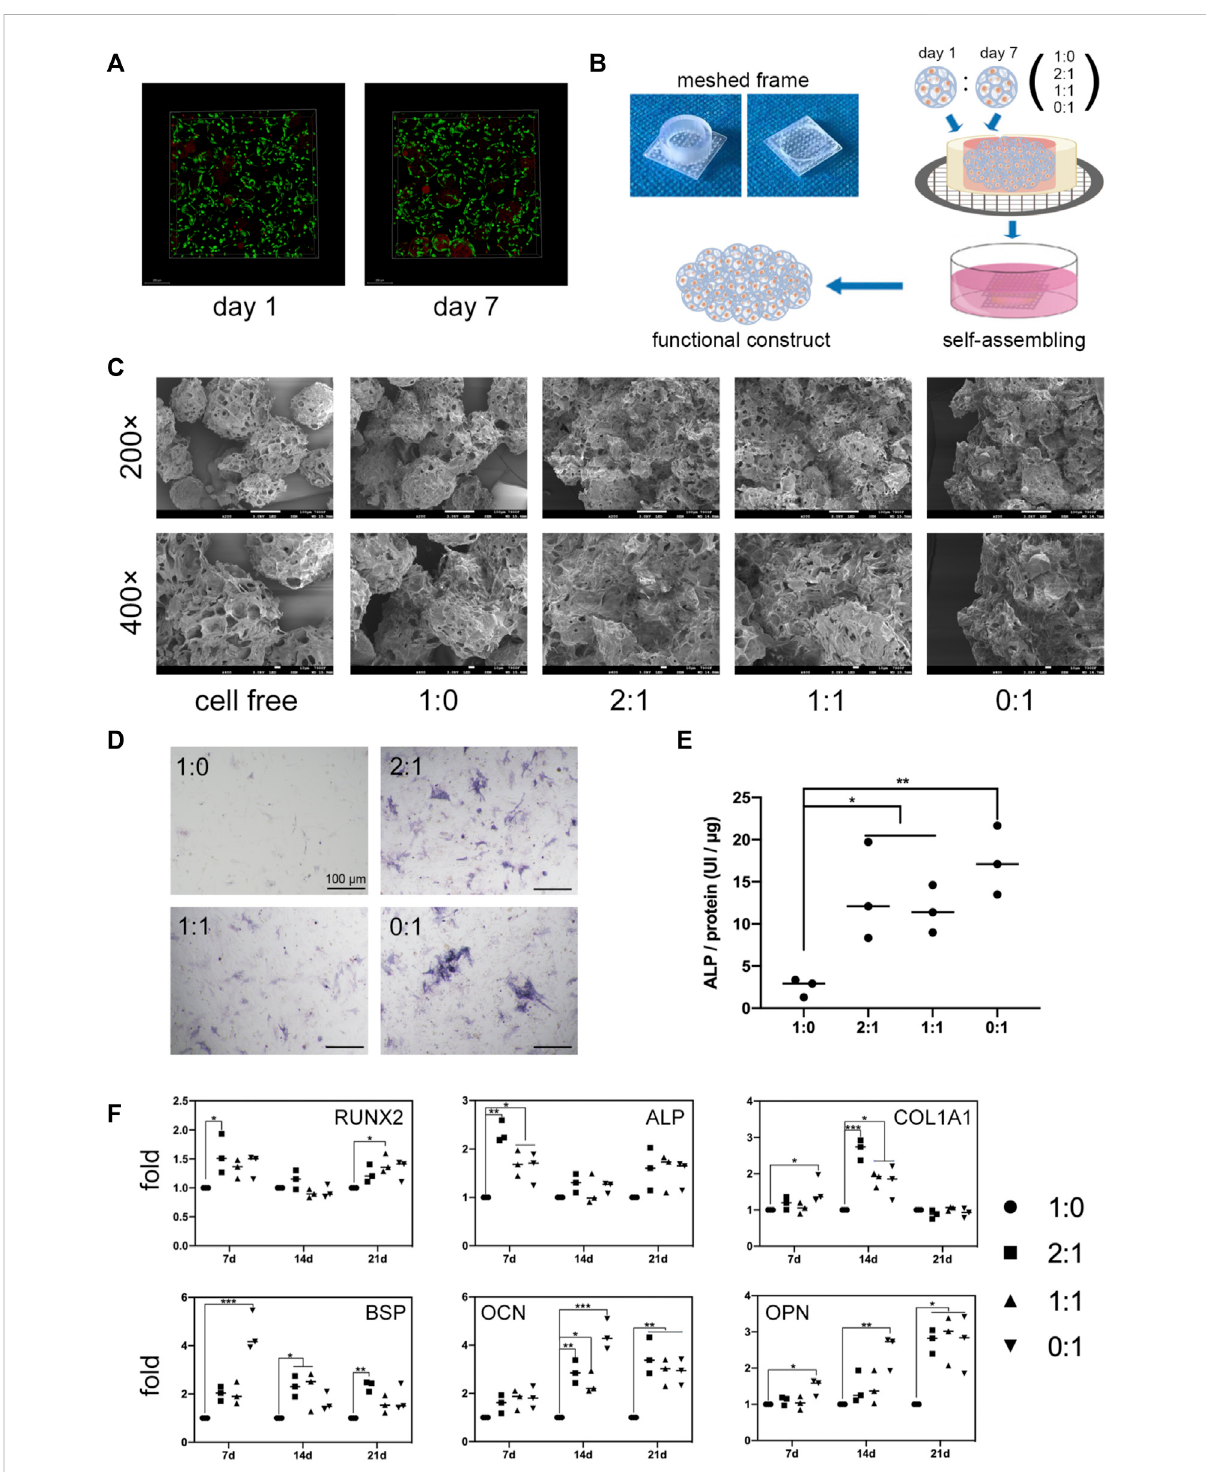
FIGURE 1 In vitro microtissue construct formation and osteogenic differentiation. (A) . Live/dead staining of MSCs after 24 h culture in growth medium within microcryogels (day 1) or after additional 6-day osteogenic induction within microcryogels (day 7). (B) . Schematic of the process of forming different group of microtissue constructs by in vitro self-assembly of MSC-loaded microtissues within meshed frames. (C) . Scanning electron microscope (SEM) images of different groups of microtissue constructs cultured in meshedframes for 7 days. (D) . ALP staining images of MSCs lysedfrom differentgroupsofmicrotissueconstructsafter 7-day self-assembly.Scalebar=100 μ m. (E) . ALPquantitative analysis ofdifferentgroups of microtissue constructs after 7-day self-assembly (* p < 0.05, ** p < 0.01). (F) . The mRNA levels of osteogenic differentiation related genes in different groups of microtissue constructs over 21 days (* p < 0.05, ** p < 0.01, *** p <